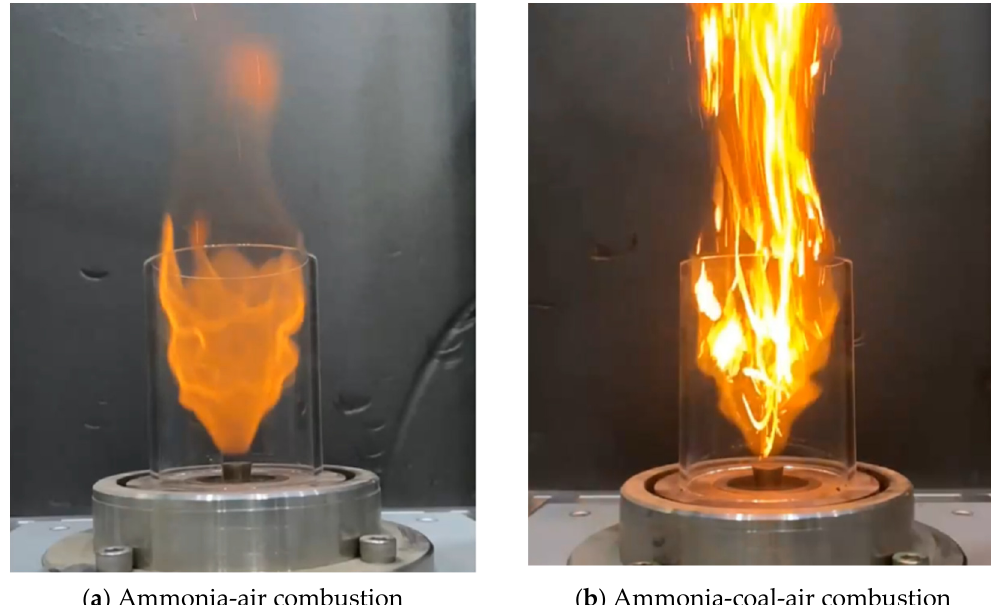
Figure 30. Flame observation results at 5 kW th capacity: ( a ) Flame visualization for 100% NH 3 combustion; ( b ) Flame vis-